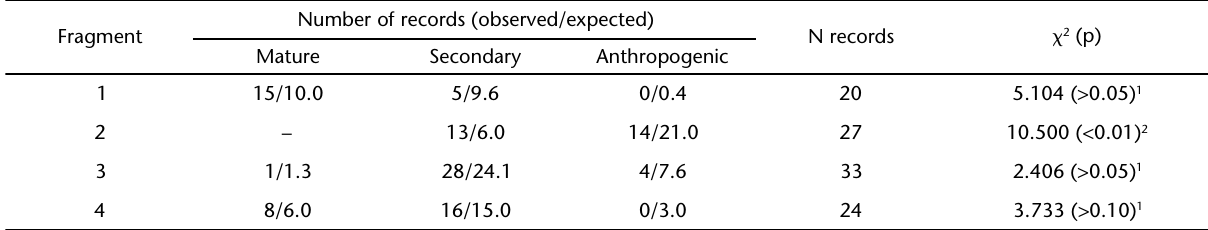
Table IV. Comparison of the number of sightings recorded (observed) and expected for C. coimbrai in each of the four fragments at the Fazenda Trapsa, according to the availability of different habitats.